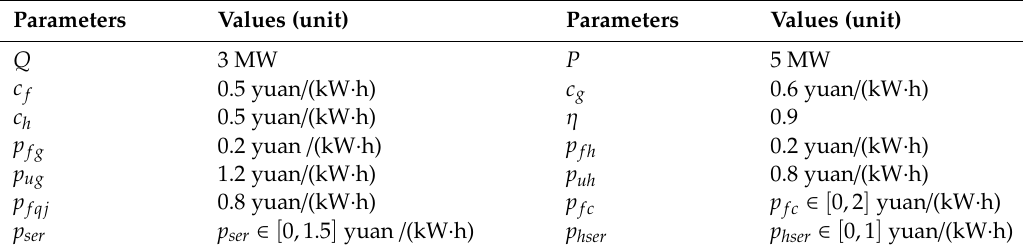
Table 1. Energy internet parameters. (Note that there is only one energy supplier in this section, namely 𝑗 = 1 ; 𝑝 𝑓𝑐𝑗 is thus simplified to 𝑝 𝑓𝑐 .)